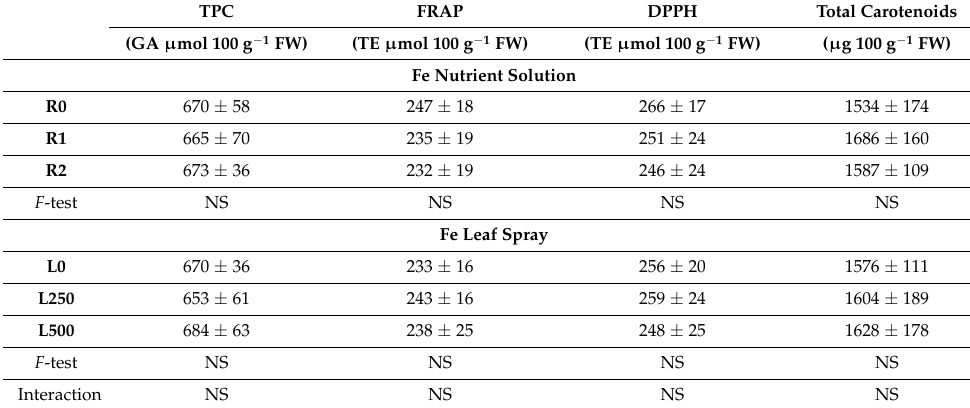
Table 3. Effects of Fe application on the biochemical traits of cherry tomato